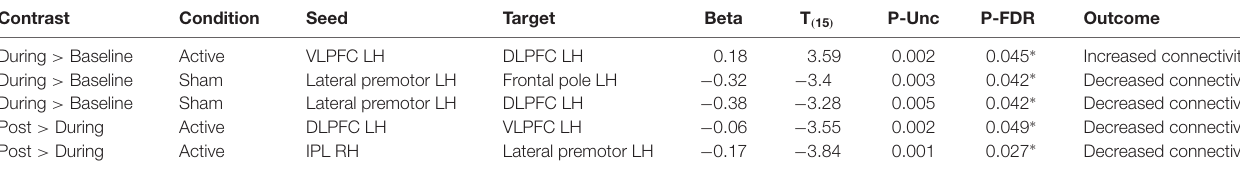
TABLE 2 | Significant seed to target connectivity values and test statistics for each